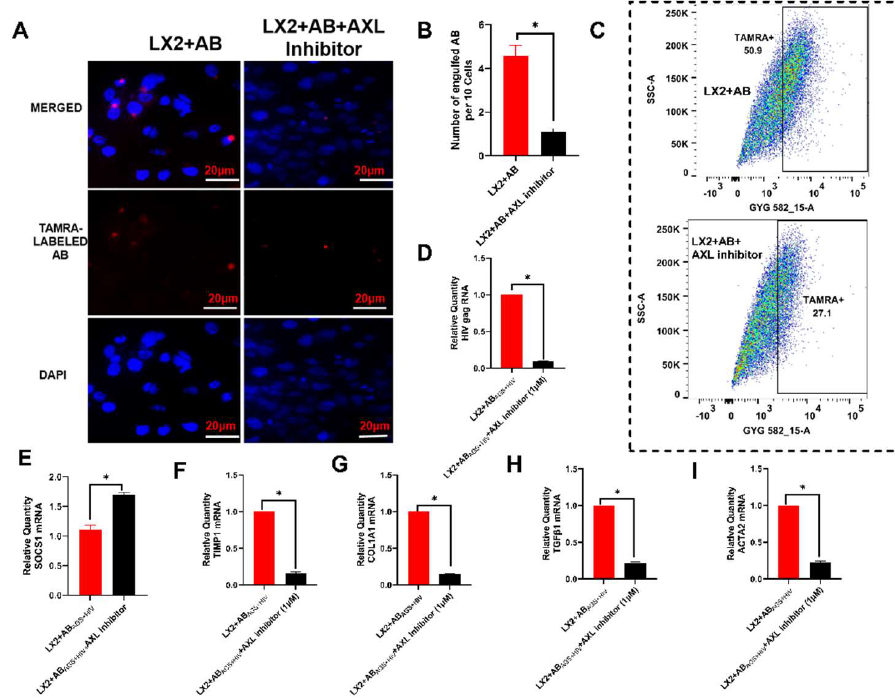
Figure 4. AXL inhibitor attenuates HIV RNA expression and profibrotic genes in LX2 cells exposed to AB AGS+HIV : ( A ) Immunofluorescence staining demonstrates the attenuation of TAMRA-labeled AB entry into LX2 cells pretreated with Axl-inhibitor. Staining was visualized using a 20 × BZ-X810 fluorescence microscope. Pictures are the representative data of three independent experiments. ( B ) Quantification of engulfed TAMRA-labelled RLW ABs by LX2 cells. Engulfment of TAMRA-labelled RLW ABs by LX2 cells was counted manually in 3 fields. ( C ) Intracellular quantification of TAMRA-labelled RLW ABs exposed to LX2 cells (flow cytometry). RT PCR analysis of: ( D ) HIV gag RNA, ( E ) SOCS1 mRNA, ( F ) TIMP1 mRNA, ( G ) COL1A1 mRNA, ( H ) TGF β 1 mRNA, and ( I ) ACTA2 mRNA. Data are from 3 independent experiments presented as mean ± SEM. * Indicates significant difference ( p ≤ 0.05).